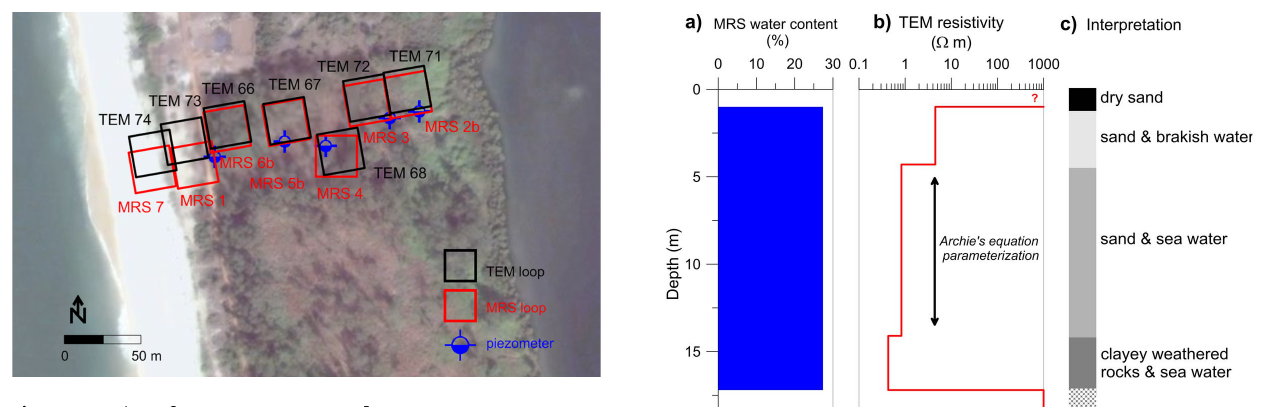
Fig. 4. Location of measurements, Profile 2.